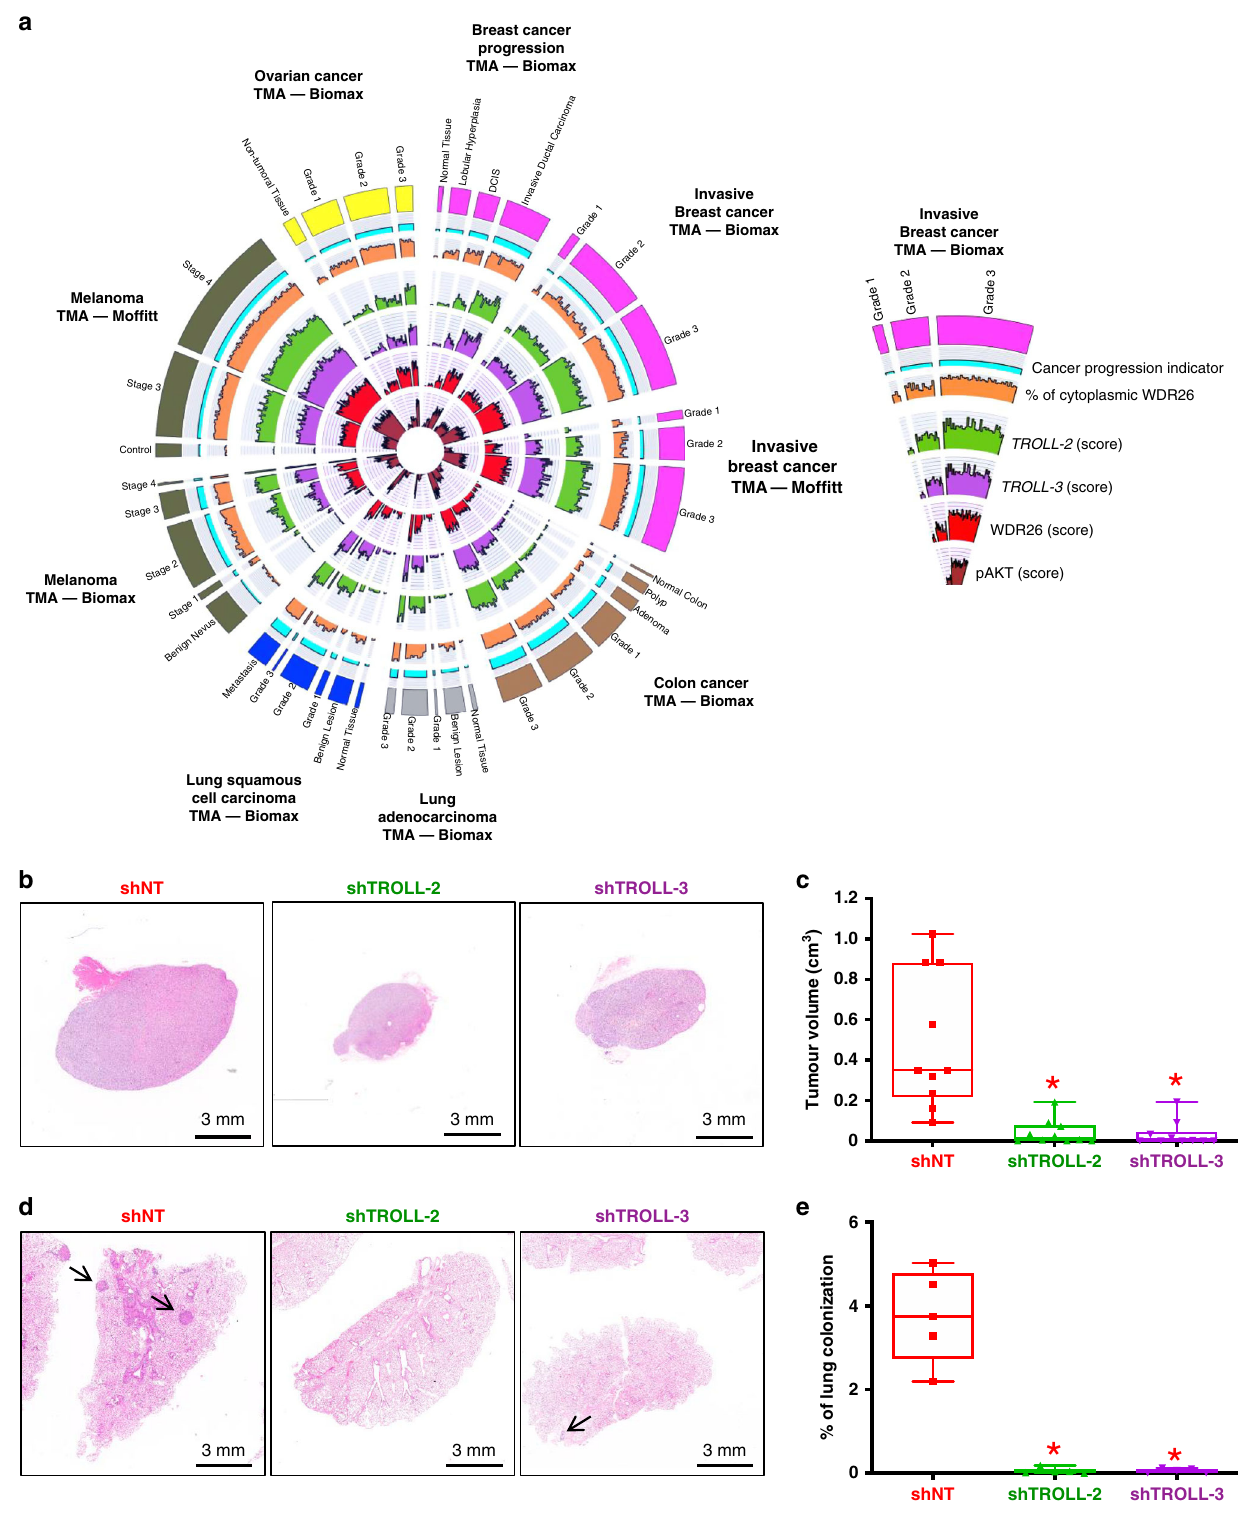
Fig. 5 Cytoplasmic WDR26 correlates with advanced cancers. a Circos plot summarizing the expression of TROLL-2, TROLL-3 , WDR26 and pAKT in TMAs of 378 cancers with progressive disease. b Representative H&E stained cross sections of melanomas derived from Malme-3M cells infected with the indicated shRNAs. c Quanti fi cation of the melanomas described in b . n = 5 mice for all groups, asterisk vs. NT, P < 0.005, two-tailed Student ’ s t test. d Representative H&E stained cross sections of lung colonies derived from Malme-3M cells infected with the indicated shRNAs. e Quanti fi cation of the lung colonies described in d . n = 5 mice for all groups, asterisk vs. NT, P < 0.005, two-tailed Student ’ s t test. Boxplots represent the individual data points, median and whiskers (min to max method). Source data are provided as Source data fi